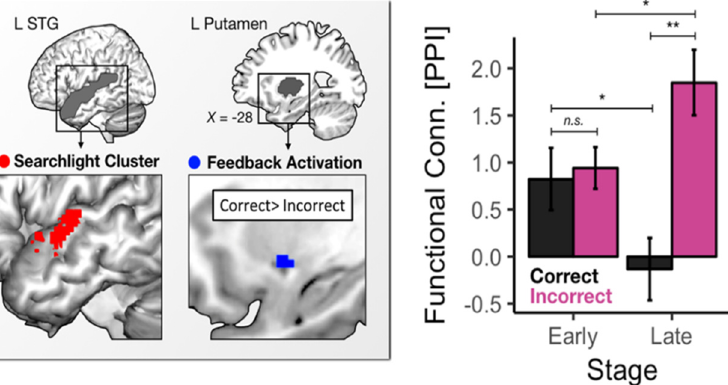
Figure 1. The emergence of neural representations for non-native speech sound categories. Variability-resistant category representations emerge within the left Superior Temporal Gyrus (STG) within a few hundred training trials. Corrective feedback engages the putamen throughout learning. These two regions are more functionally coupled during incorrect feedback (towards the latter half of training) relative to correct feedback. * and ** indicate increasing levels of statistical significance in planned t-tests. Adapted with permission from Feng et al. (2019). Copyright 2019 The Authors.